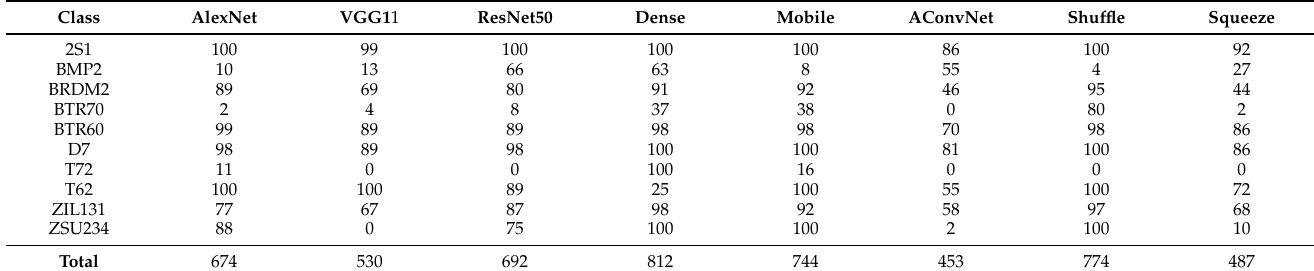
Table 6. Detailed fooling ratio (%) on each class. The attack is CosSim-UAP with MobileNetV2 as the substitute model. Results of DF-UAP and GD-UAP can be found in Tables A5 and